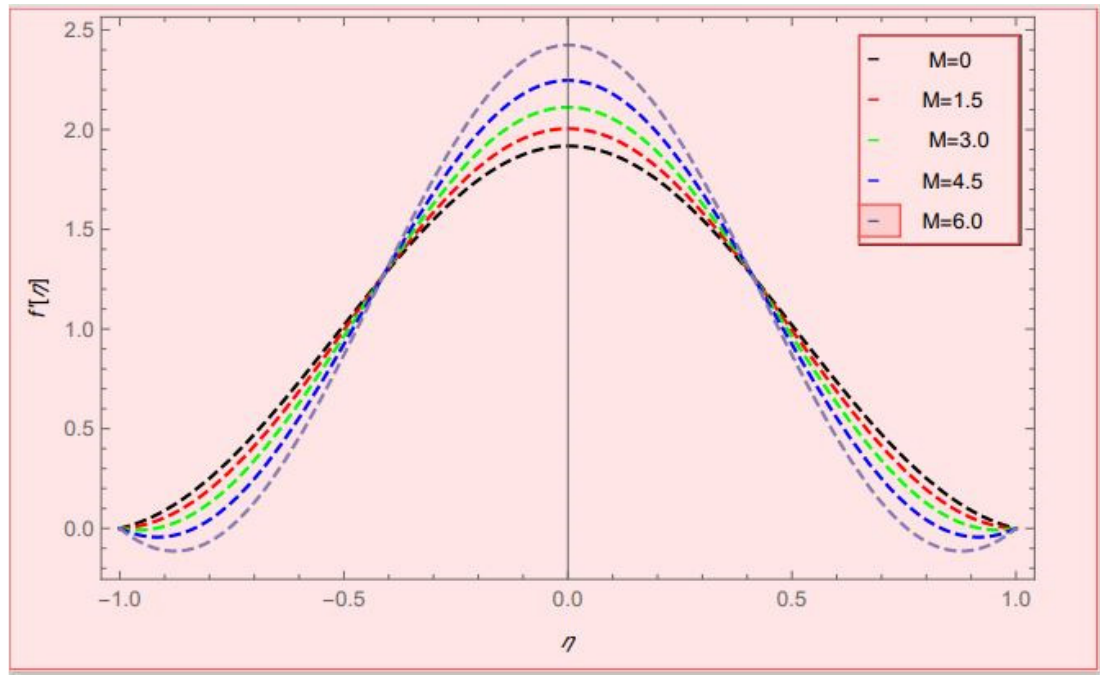
Figure 8. Velocity profile effect against the magnetic parameter (M) for α = 3.2, Pr = 0.1, Nt = Nb = 0.7, Re = 2.5, β = 2, Br = 0.1, ϕ 1 = ϕ 2 = 0.02, h = 2, r = 1.5.